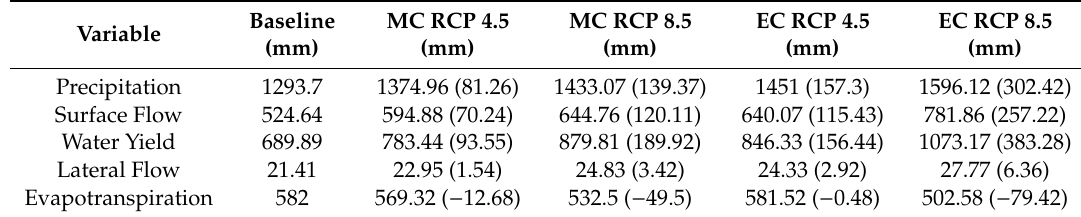
Table 5. Average annual water balance for mid-century (MC; 2046–2065) and end-century (EC; 2081–2099) under RCP 4.5 and 8.5 from baseline